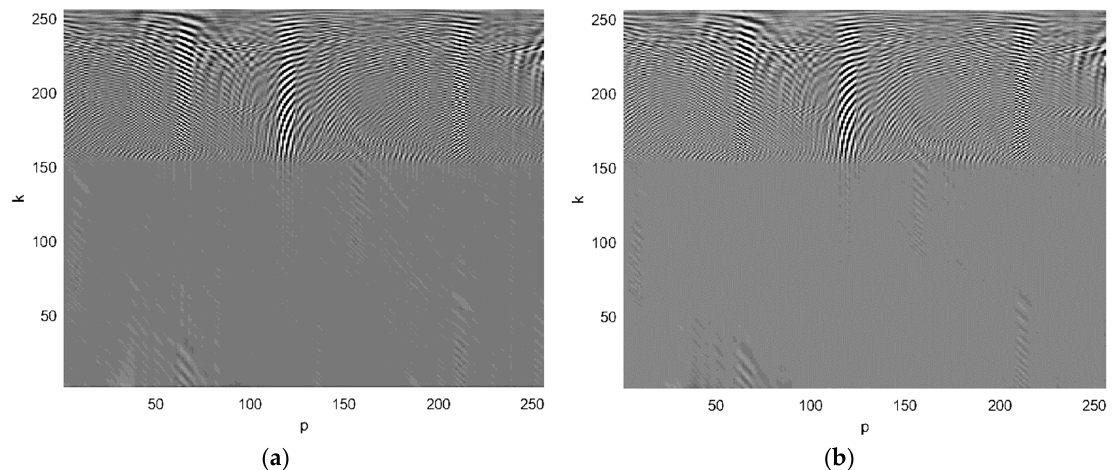
Figure 4. The quadrature components of the demodulated complex SAR signal, the real part ( a ) and imaginary part ( b ).